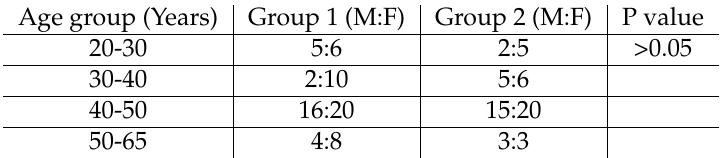
Table 1. Age and gender distribution of cases used in study